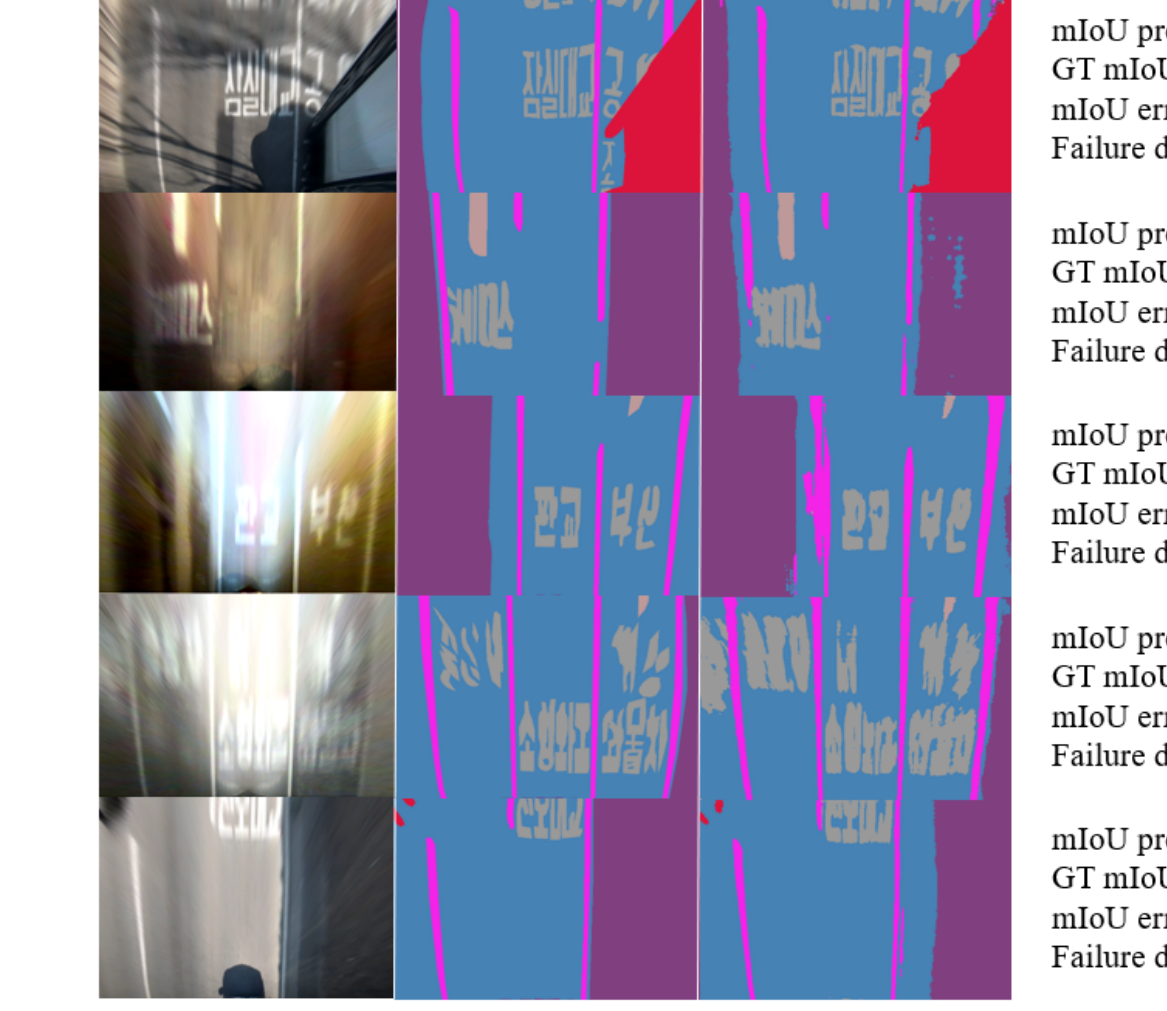
Figure 14. Examples of false-negative images on the Hyundai Motor Group (HMG)